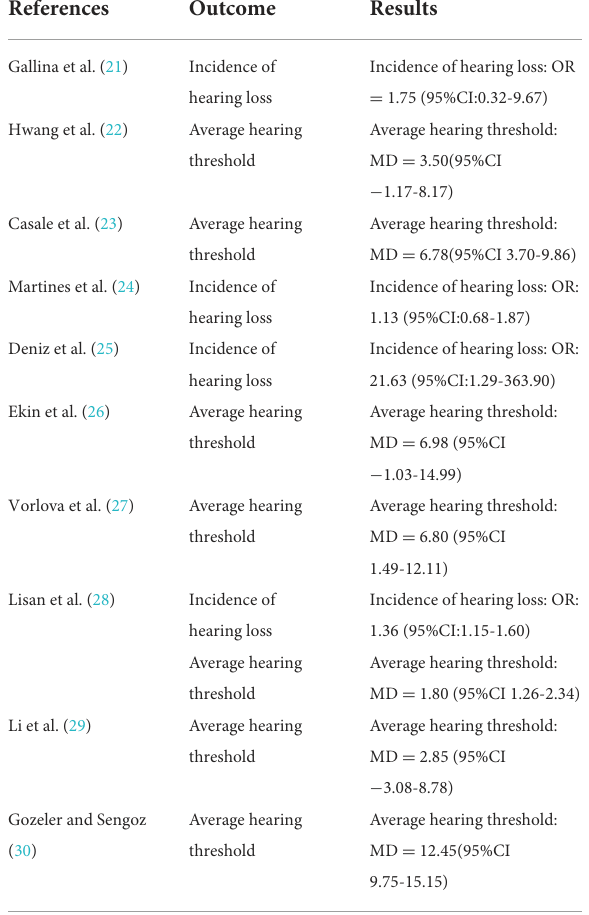
TABLE 3 The effect size value for mean differences of the included